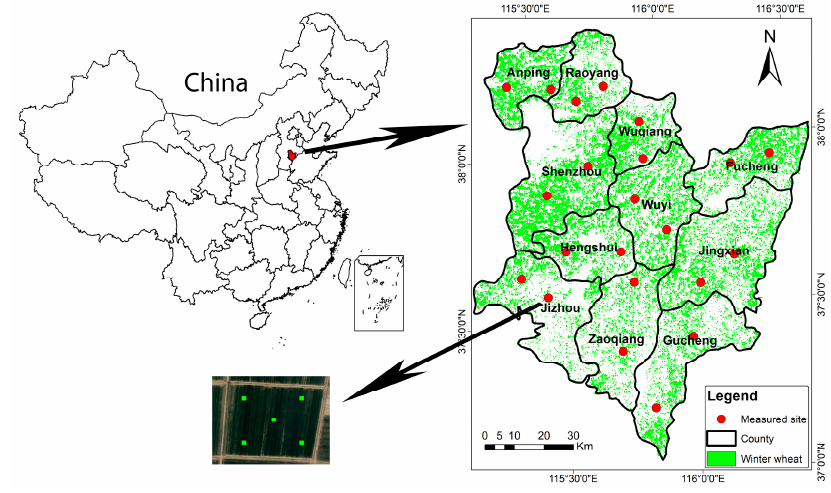
Figure 1. Study area. (Every county has 2 measured sites; each site has 5 sample points).